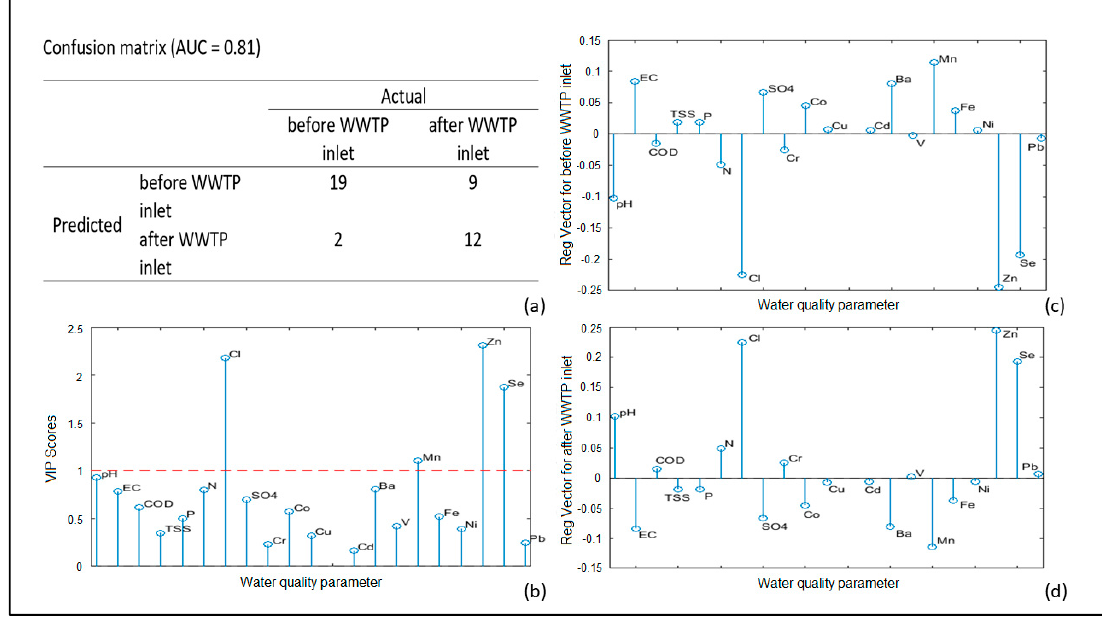
Figure 3. The PLS-DA model results for surface waters before and after WWTP outlet based on physicochemical water quality parameters: ( a ) Confusion matrix; ( b ) VIP scores; ( c ) Regression vectors for WWTP effluents; ( d ) Regression vector for surface waters.